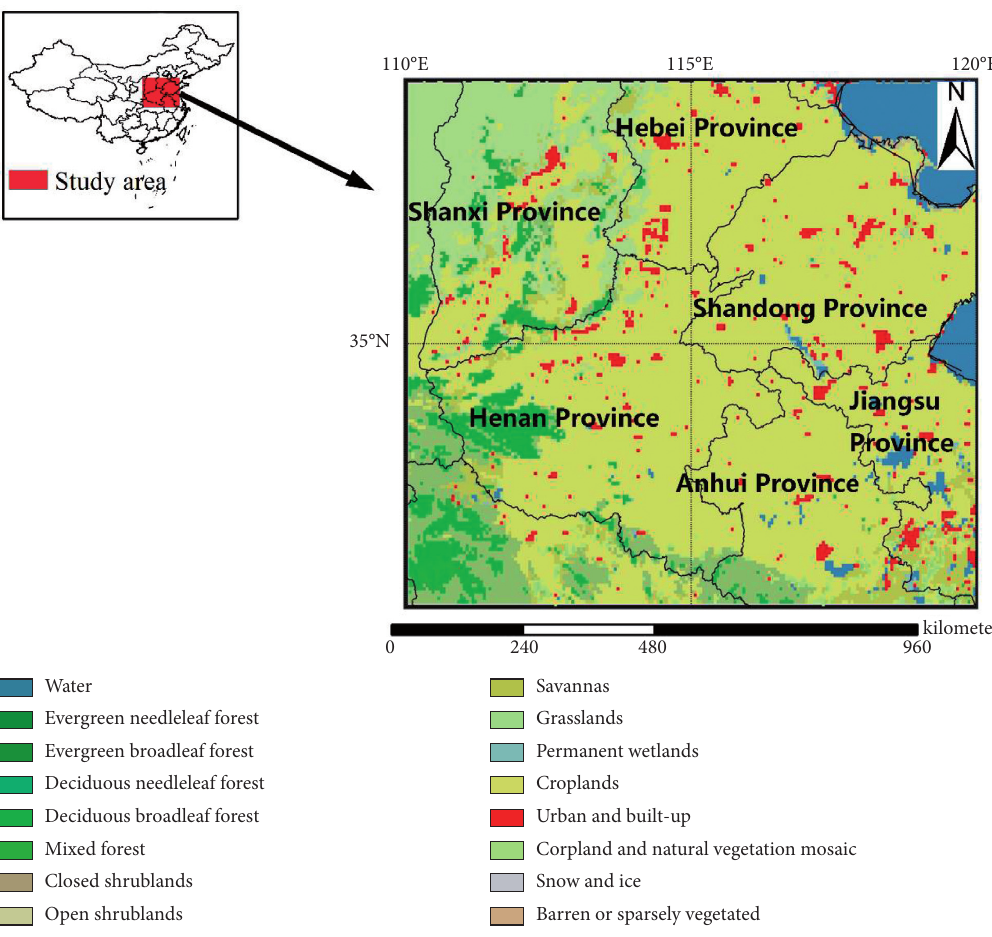
Figure 1: The location and land cover of the study area. The 2014 MODIS land cover map with IGBP land cover classification at 0.05-degree spatial resolution is